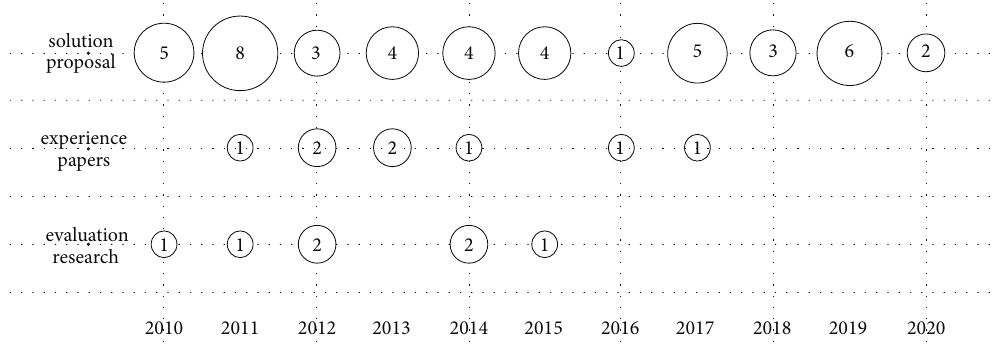
Figure 5: The number of research types per year.